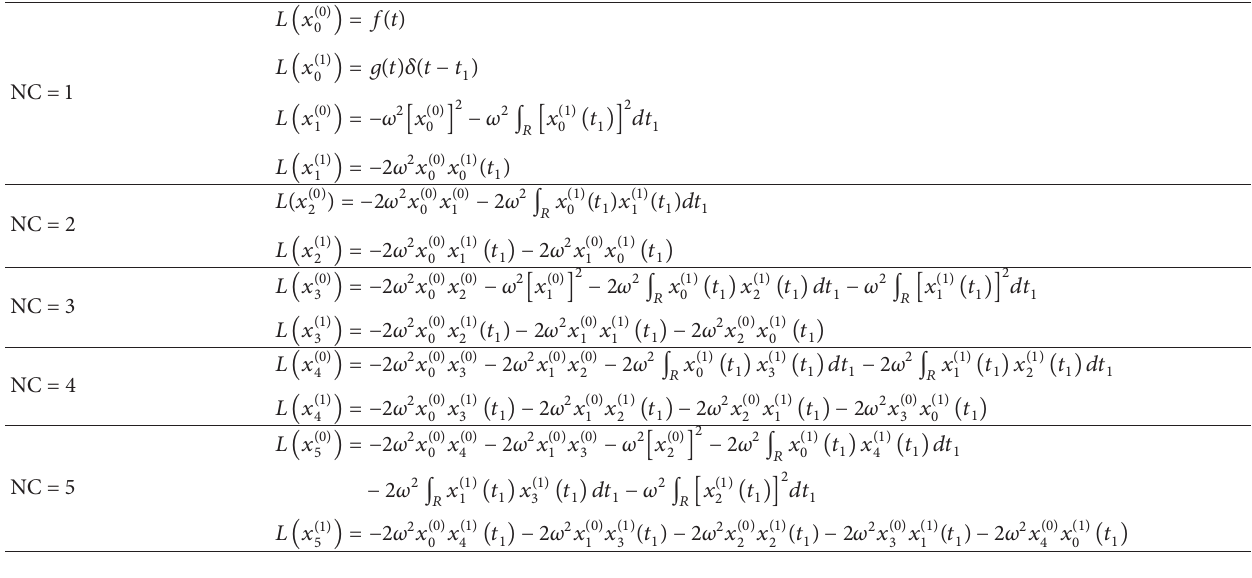
Table 1: The equivalent deterministic system for first-order approximation with different number of corrections (NC).